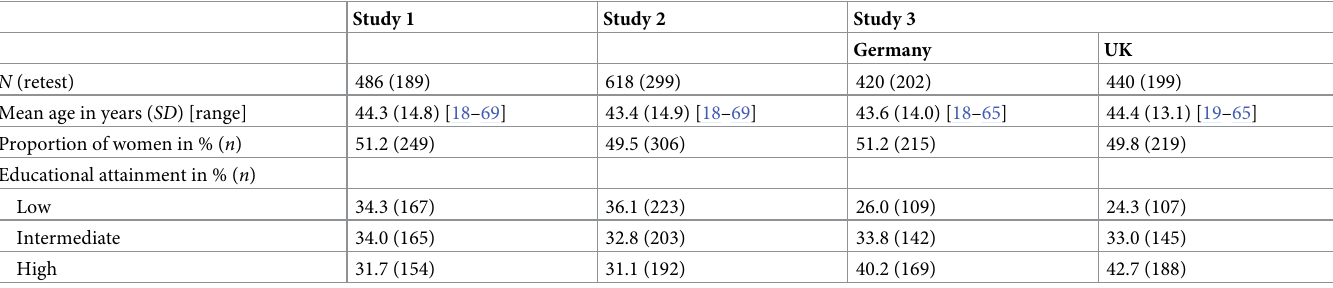
Table 1. Sample characteristics by